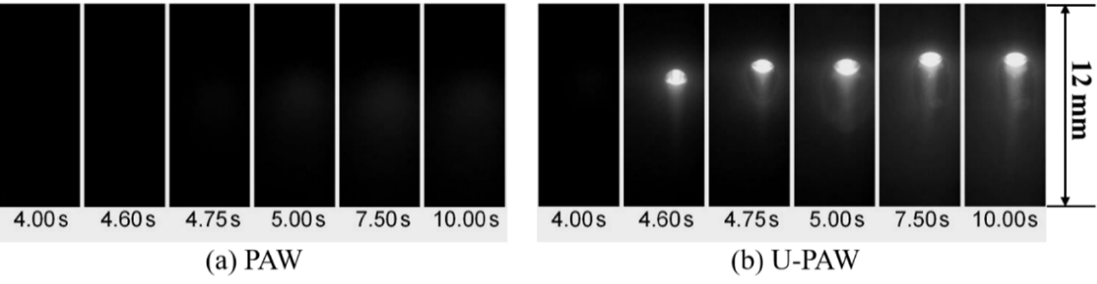
Figure 6. The captured images of the keyhole exit ( a ) PAW ( b ) U-PAW.